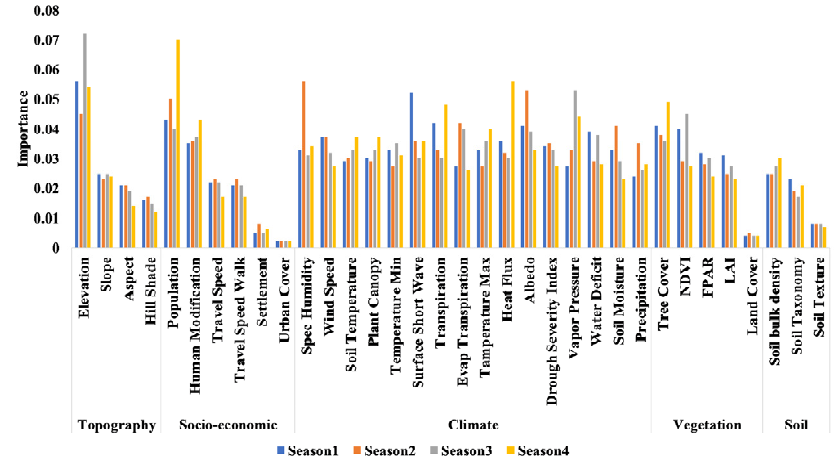
Figure 23. Seasonal variable importance analysis based on the RF model.